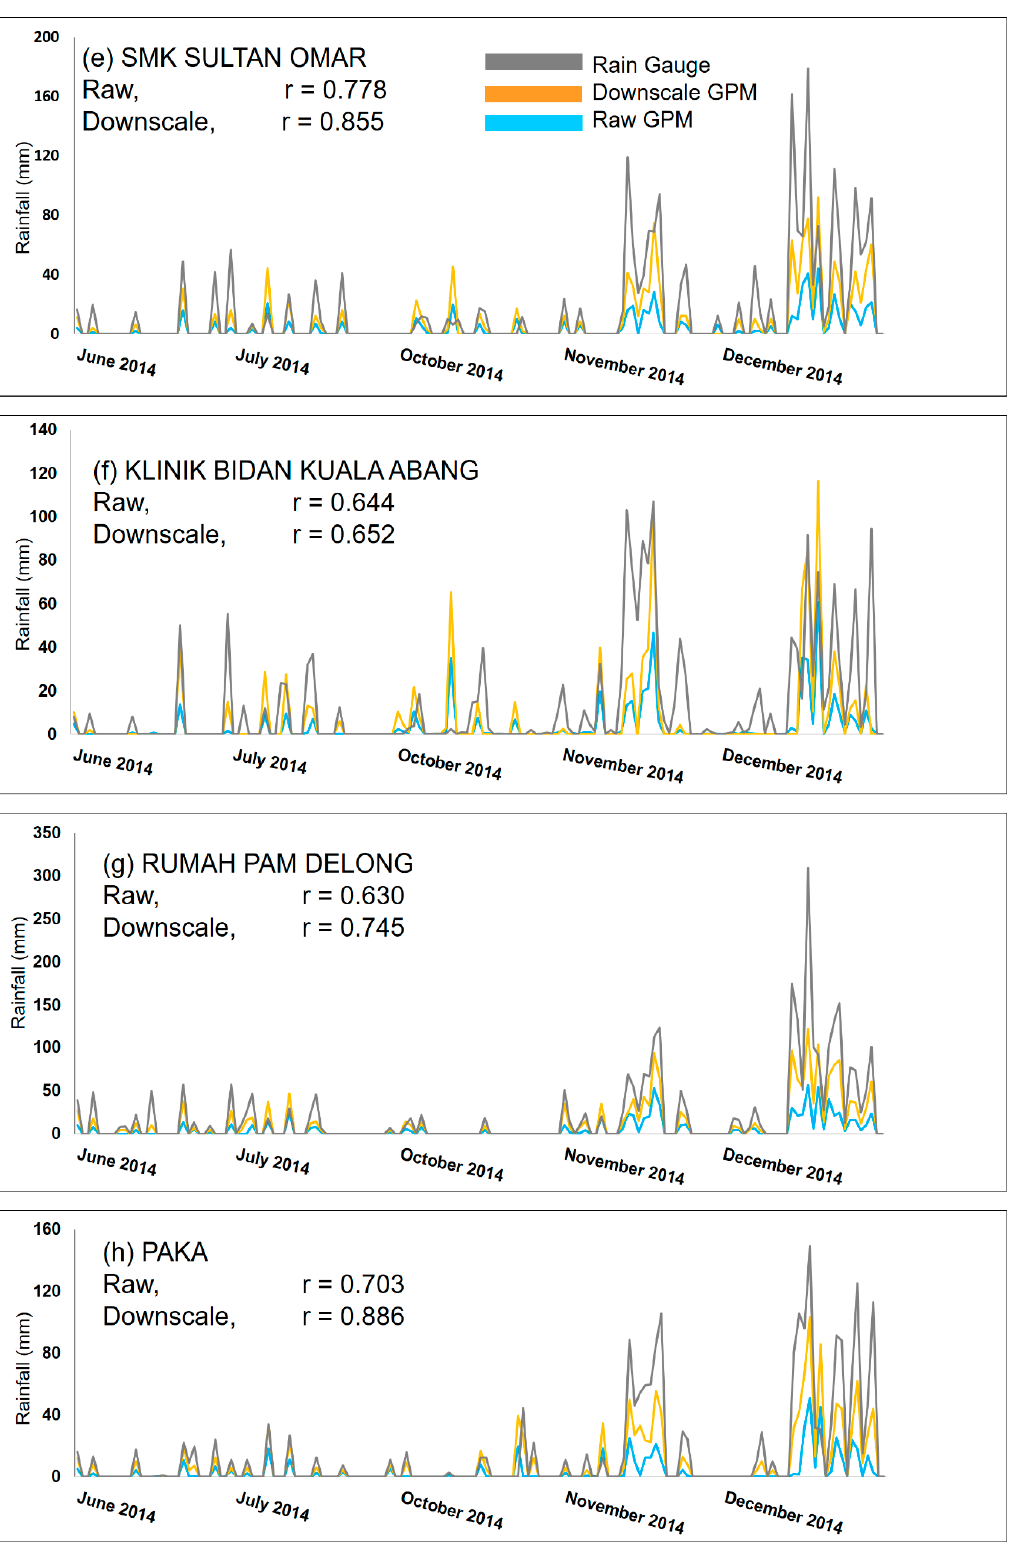
Figure 8. Time-series between the rain gauge, raw and downscaled Global Precipitation Mission (GPM) at rain gauge stations. Rain days below than 10 mm/day were considered as low rainfall days and excluded in the calculation.